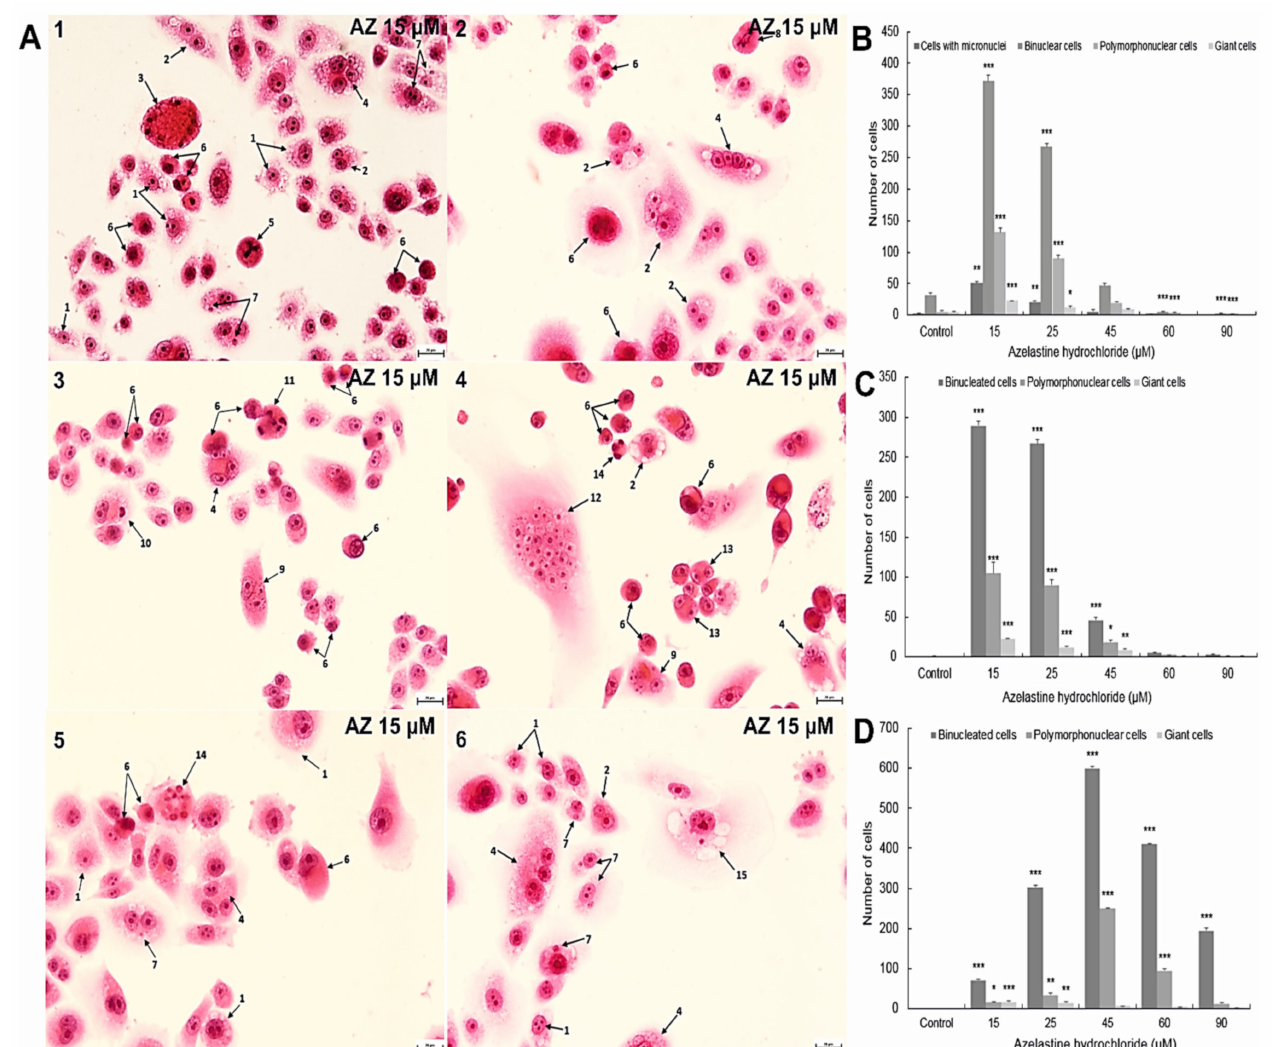
Figure 5. Morphological markers of mitotic catastrophe induced in HeLa cells exposed to 48 h treatment of azelastine hydrochloride. ( A ) Intensified changes (multipolar mitosis, micronucleation, and multinucleation) in cells treated with 15 µ M azelastine. Explanation of markings: 1—cells with vacuolization, 2—binucleated cells with vacuolization, 3—apoptotic giant cell, 4—multinucleated cells with vacuolization, 5—tripolar metaphase, 6—apoptotic cells, 7—cells with micronuclei, 8—anaphase bridges, 9—multinucleated cells with micronuclei, 10—efferocytosis, 11—pentapolar anaphase, 12—giant cells, 13—binucleated cells in apoptosis, 14—multinucleated cells in apoptosis, 15—giant cells with vacuolization and micronuclei. Hematoxylin and eosin staining. Images were taken at a magnification of 4000 × . ( B ) Distribution of cells with micronuclei, bi-, multinucleated cells, and giant cells at different concentrations of azelastine 15–90 µ M. Azelastine concentration-dependent induction of vacuolization ( C ) and apoptotic ( D ) changes in bi-, multinucleated, and giant cells. Average values from three independent experiments. The differences were statistically confirmed at: * p < 0.05, ** p < 0.01, *** p <